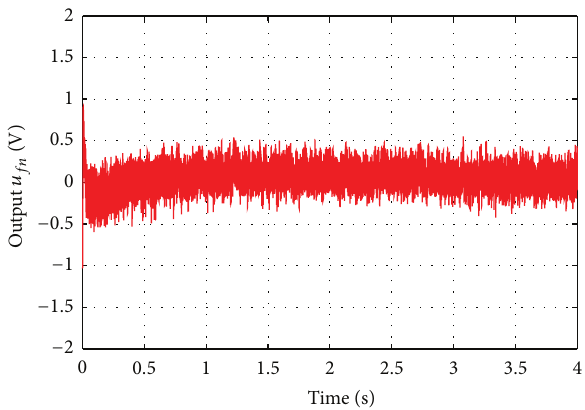
Figure 20: The output of RBFNN.